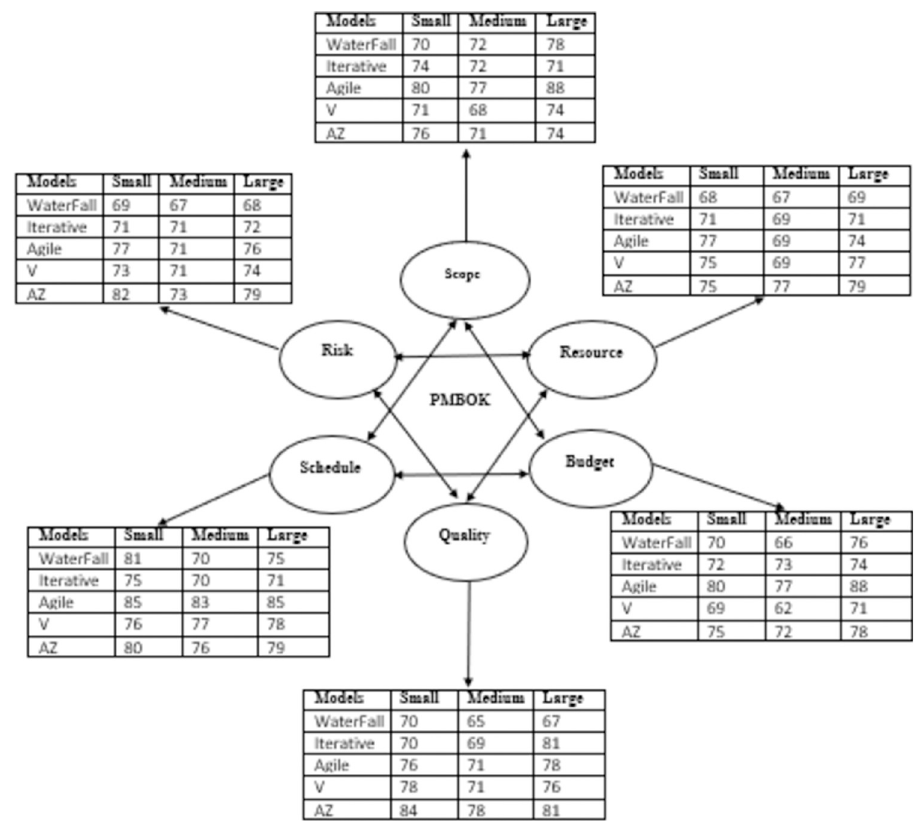
Fig 13. Result summary of different development models using PMBOK methodology.